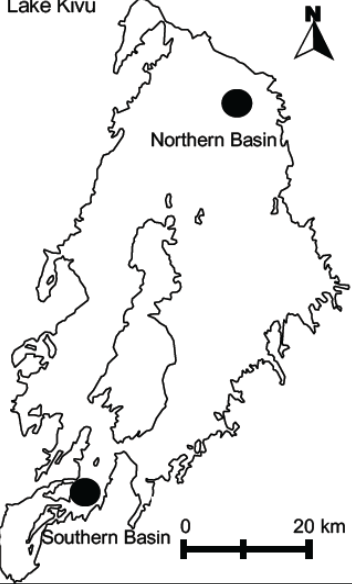
Figure 1. Map of Lake